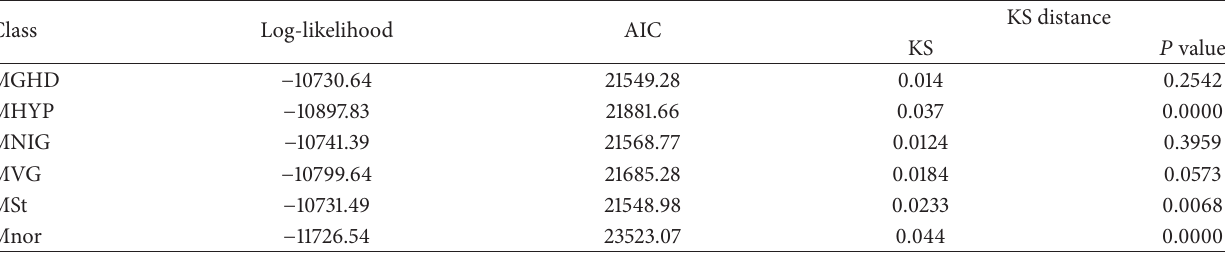
Table 5: Log-likelihood, AIC, and KS distance.